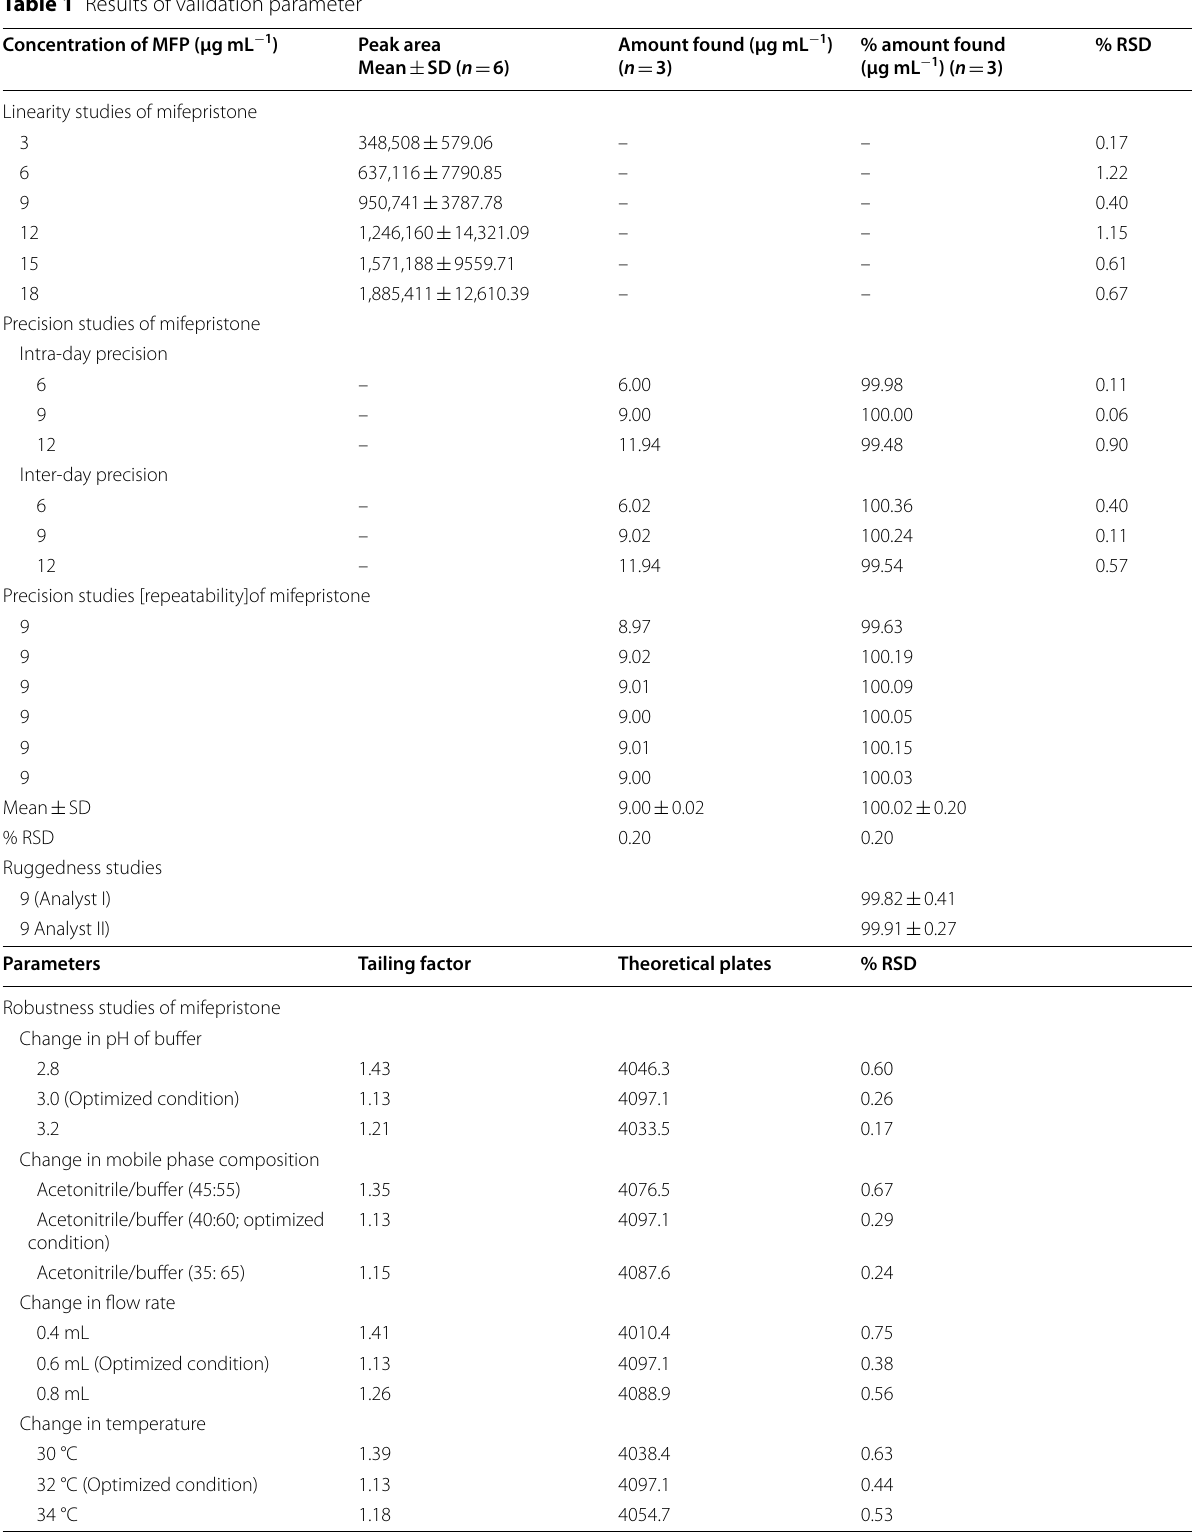
Table 1 Results of validation